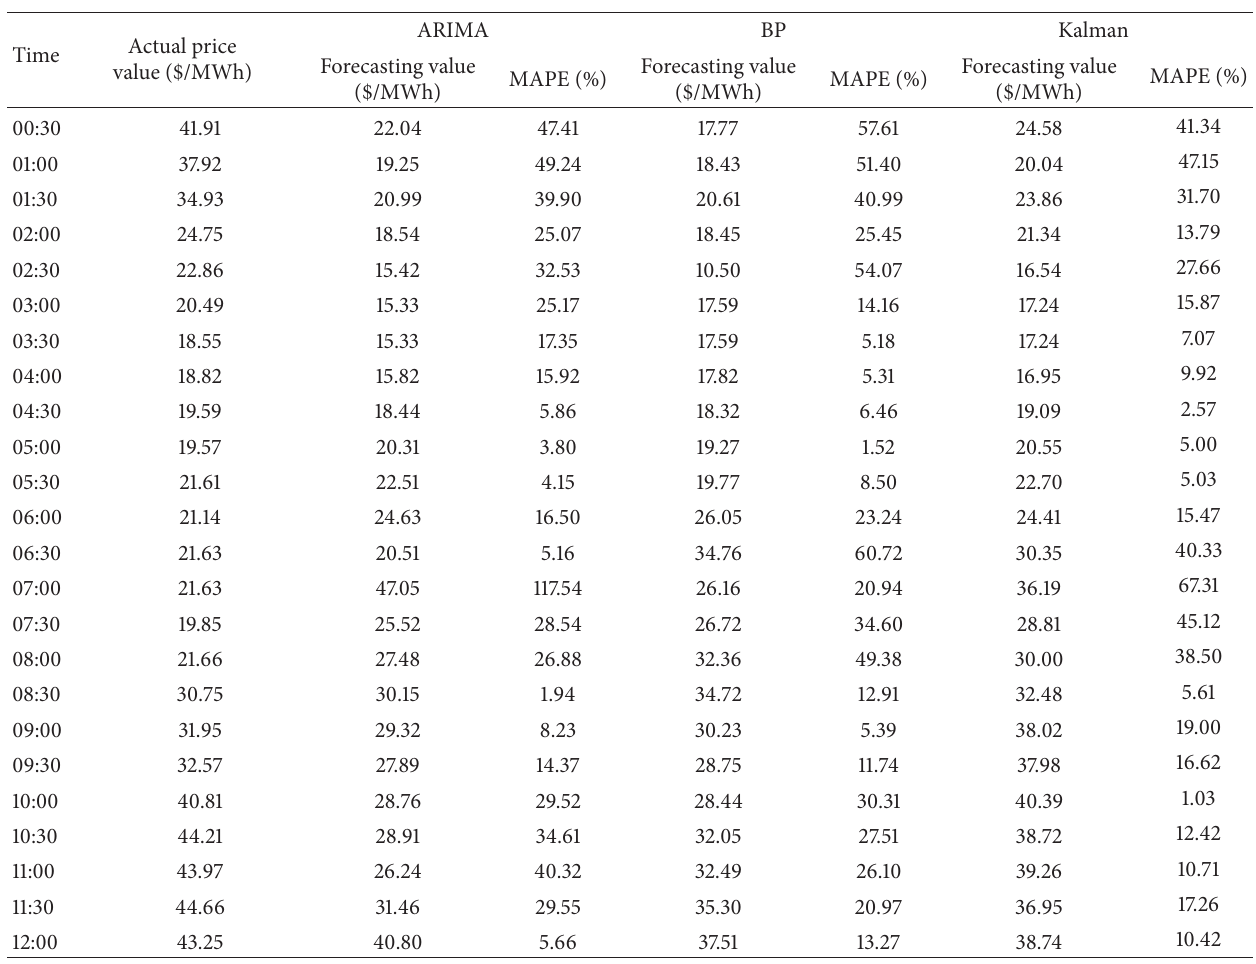
Table 2: The forecasting results of three individual models.